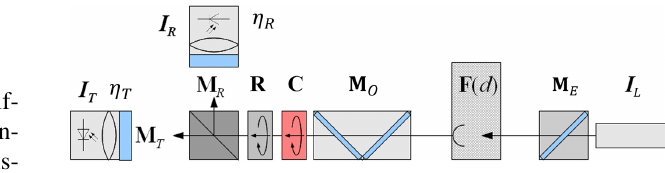
Figure 1. Lidar scheme based on functional blocks (adapted from Freudenthaler, 2016a). From right to left: laser ( I L ) , steering op- tics ( M E ) , atmosphere ( F ) , receiving optics ( M O ) , calibrator ( C ) , additional rotation of the PBS by 90 ◦ ( R ), polarizing beam-splitter cube (transmitted ( T ) and reflected ( R ) matrices, M T and M R ) , and the transmitted ( T ) and reflected ( R ) signals ( I T and I R )